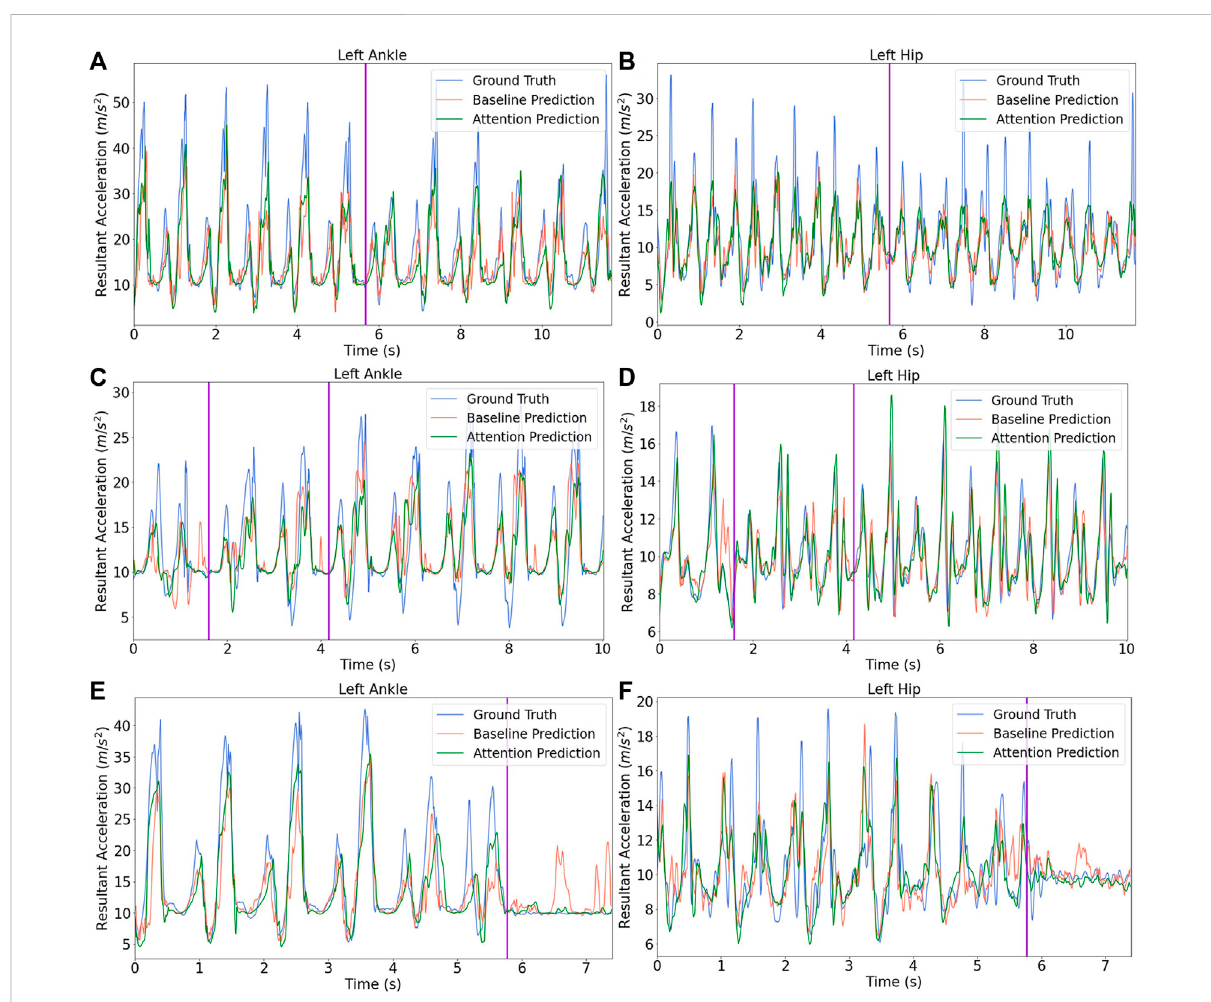
FIGURE 6 Model prediction on testing data across varied activities. The activity transitions are marked by purple vertical lines. (A) and (B) depict the transitionfromwalkinguphilltodownhillforankleandhip,respectively. (C) and (D) fi rstpresentthetransitionfromwalkingupstairstodownstairsand thenshowtheswitch fromstairdescenttolevel-walking forankleandhip,respectively. (E) and (F) showthetransitionfromlevel-walkingtostopped for ankle and hip, respectively.